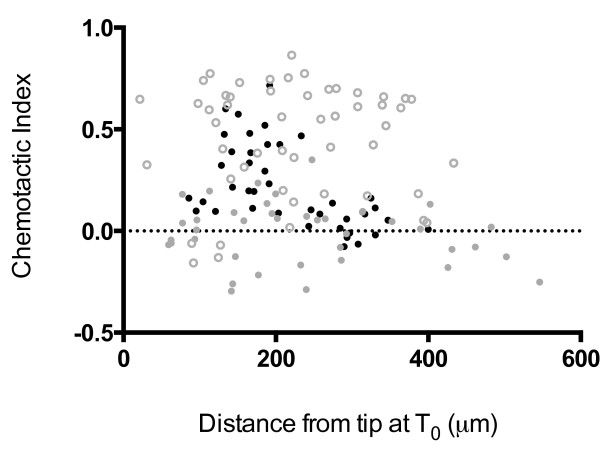
The effect of distance on folate chemotaxis of bacterially grown rasG-/rasC- cells. Chemotaxis index values plotted against distance from micropipette at T0. N = 40: Bacterially grown JH10 cells (open grey circles); bacterially grown rasG-rasC- cells (closed black circles); axenically grown rasG-rasC- cells (closed grey circles).